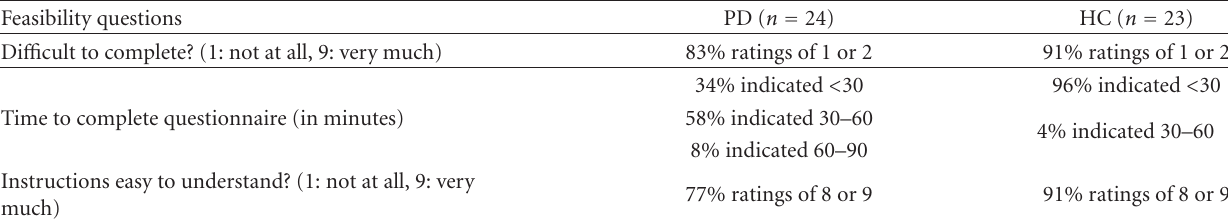
Table 2: Questionnaire feedback collected